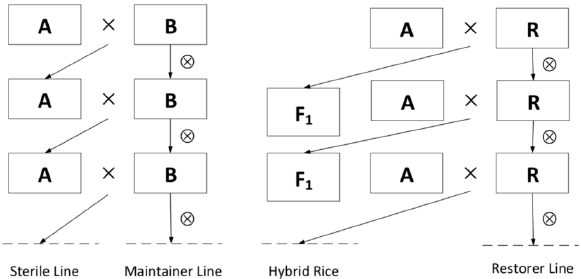
Figure 1. Breeding mechanism of three-line Chinese hybrid rice.